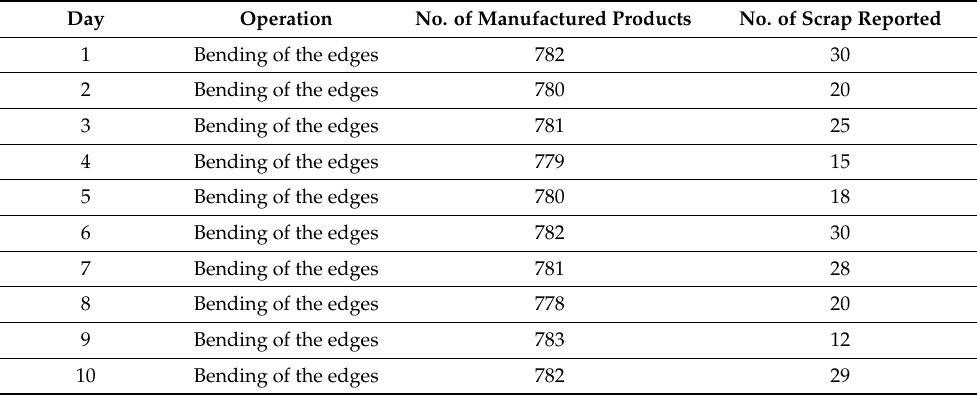
Table 5. Incidence of scrap related to the number of parts